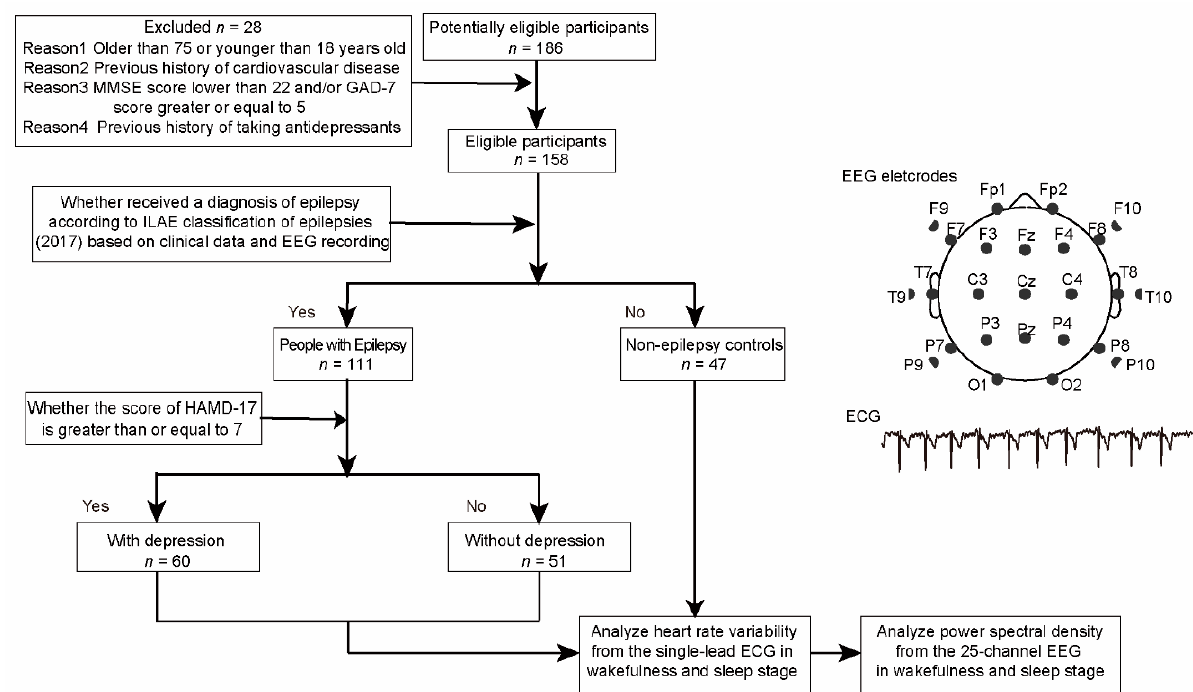
Figure 1. Flowchart of the study. Workflow for subjects included in the study (on the left) and channel locations of EEG and representative ECG trace (on the right). HAMD-17—17-item Hamilton Depression Scale; MMSE—Mini Mental State Examination; GAD-7—Generalized Anxiety Disorder-7; ECG—electrocardiography; EEG—electroencephalography.